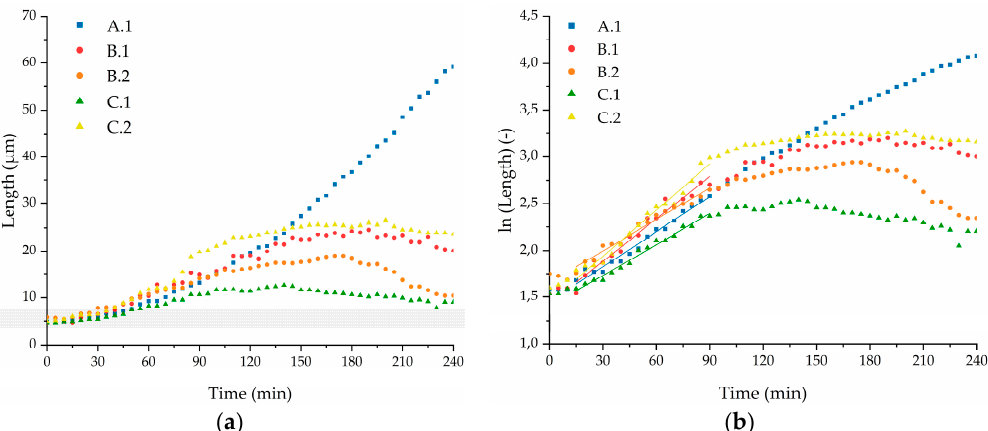
Figure 7. ( a ) Length development over time of selected E. coli cells. ( b ) Logarithmic length of E. coli cells over time with linear fits for specific growth rate determination between 15 min and 90 min of growth experiments in TB medium at 37 °C.